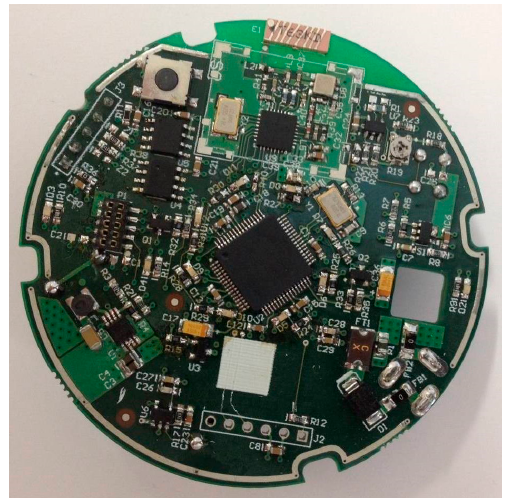
Figure 2. Gas sensing node.